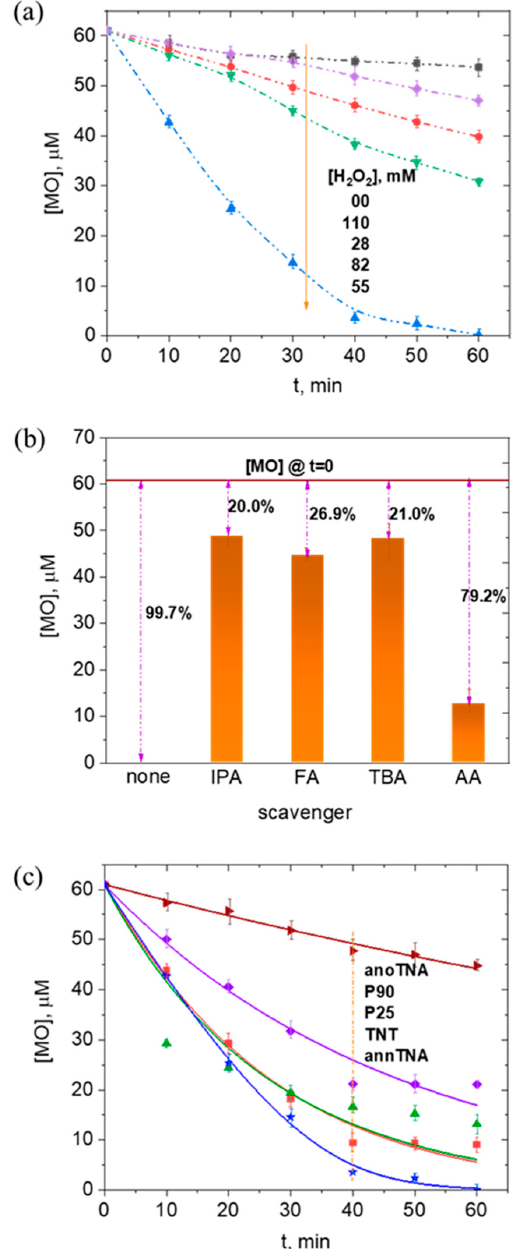
Figure 3. ( a ) Effect of H 2 O 2 concentration on MO dye degradation. The legend indicates the concentration of H 2 O 2 in mM. ( b ) MO dye degradation rate plotted with equivalent quantities of different radical scavenges. IPA, FA, TBA, and AA refer to isopropanol, formic acid, tert-butanol, and ascorbic acid, respectively. The numbers represent the MO dye degradation rate in the solution after light irradiation for 1 h. ( c ) Effect of different types of titania catalyst materials on MO degradation. The symbols indicate kinetic measurements and the solid lines are nonlinear regressions with the L–H